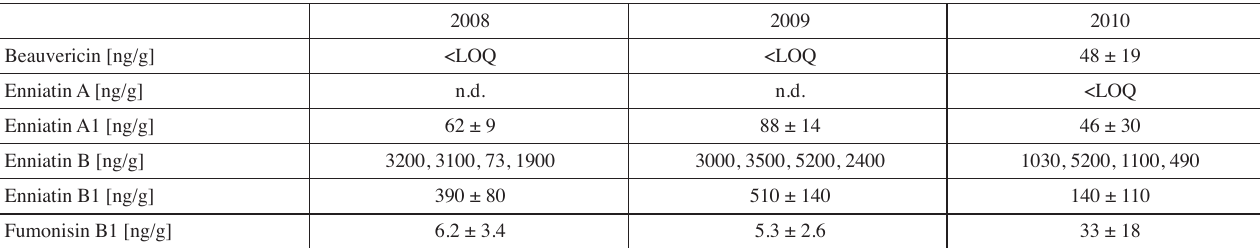
Tab. 3: Lower boundary for the content of fumonisin B1, beauvericin and enniatins The content of fumonisins and depsipeptides was determined in samples that were stored for 4 to 6 years in acetonitrile-water at -20°C. Because stability of mycotoxins under these conditions is unknown, we regard the values as lower boundaries for mycotoxin content in freshly harvested kernels. Mean of four plots per year ± standard deviation is shown except for enniatin B, for which all four values are listed. Limit of detection (LOQ) was 3 ng/g for fumonisin B1 and 14 ng/g for the other mycotoxins. “n.d.”: signal not detectable; “<LOQ”; positive signals too low to be